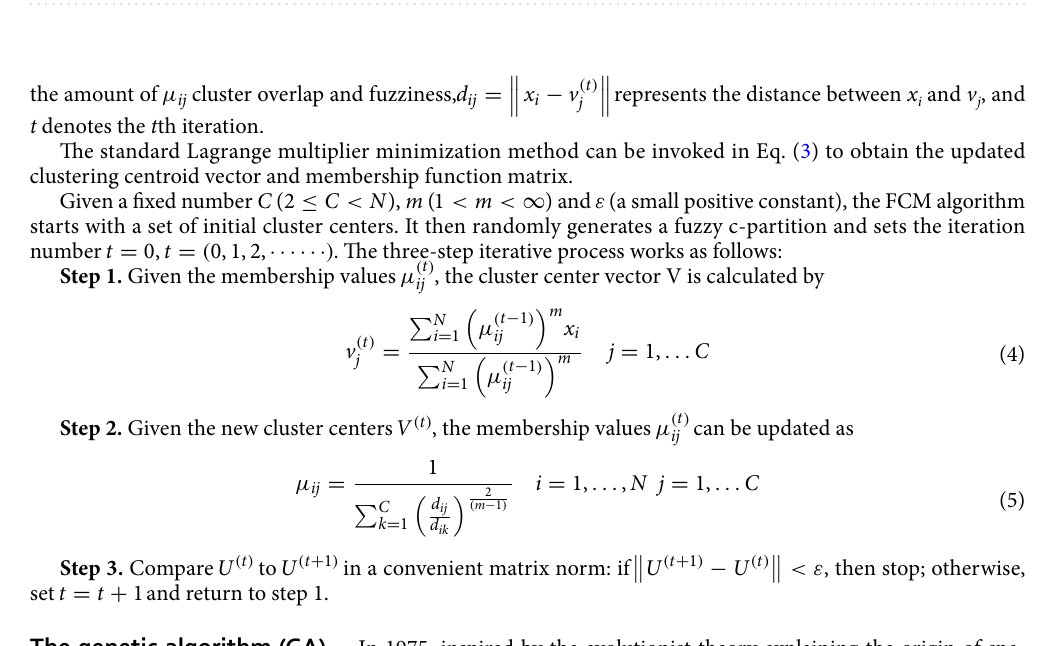
Figure 1. Overall flow chart of manufacturing resources